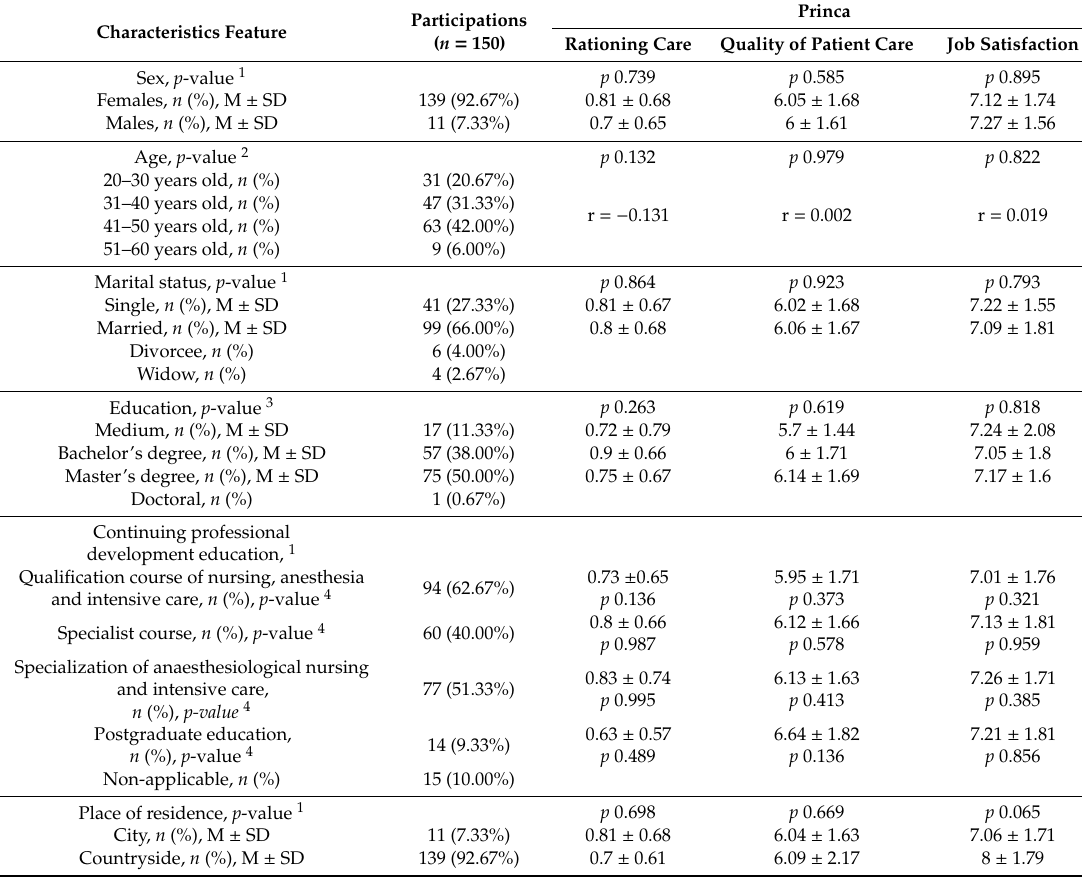
Table 1. Demographic characteristics of nurses compared with the rationing of nursing